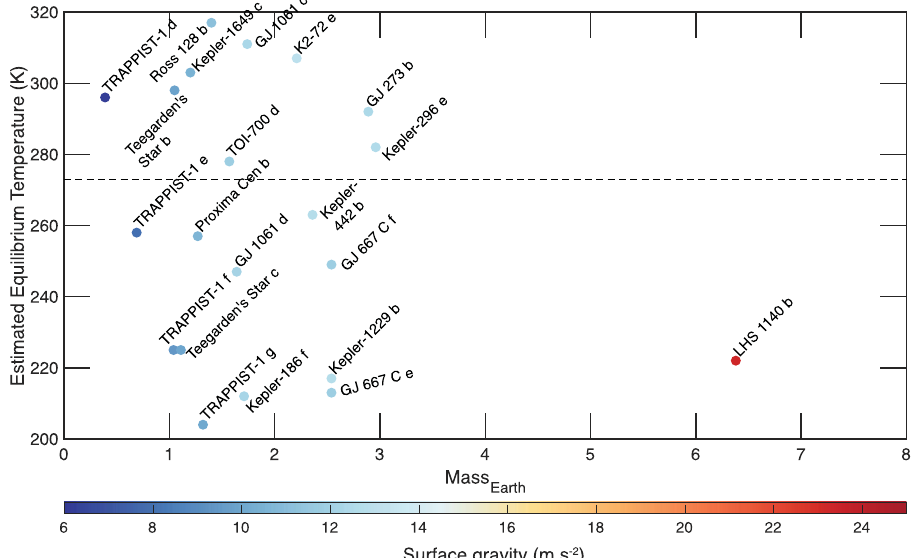
Fig. 1 | Estimatedequilibrium temperature ( T eq ) and mass(relative to Earth)of various M-dwarf orbiting exo-Earths with a high Earth Similarity Index value. The colors of the plot show the estimated surface gravity, and the dashed line